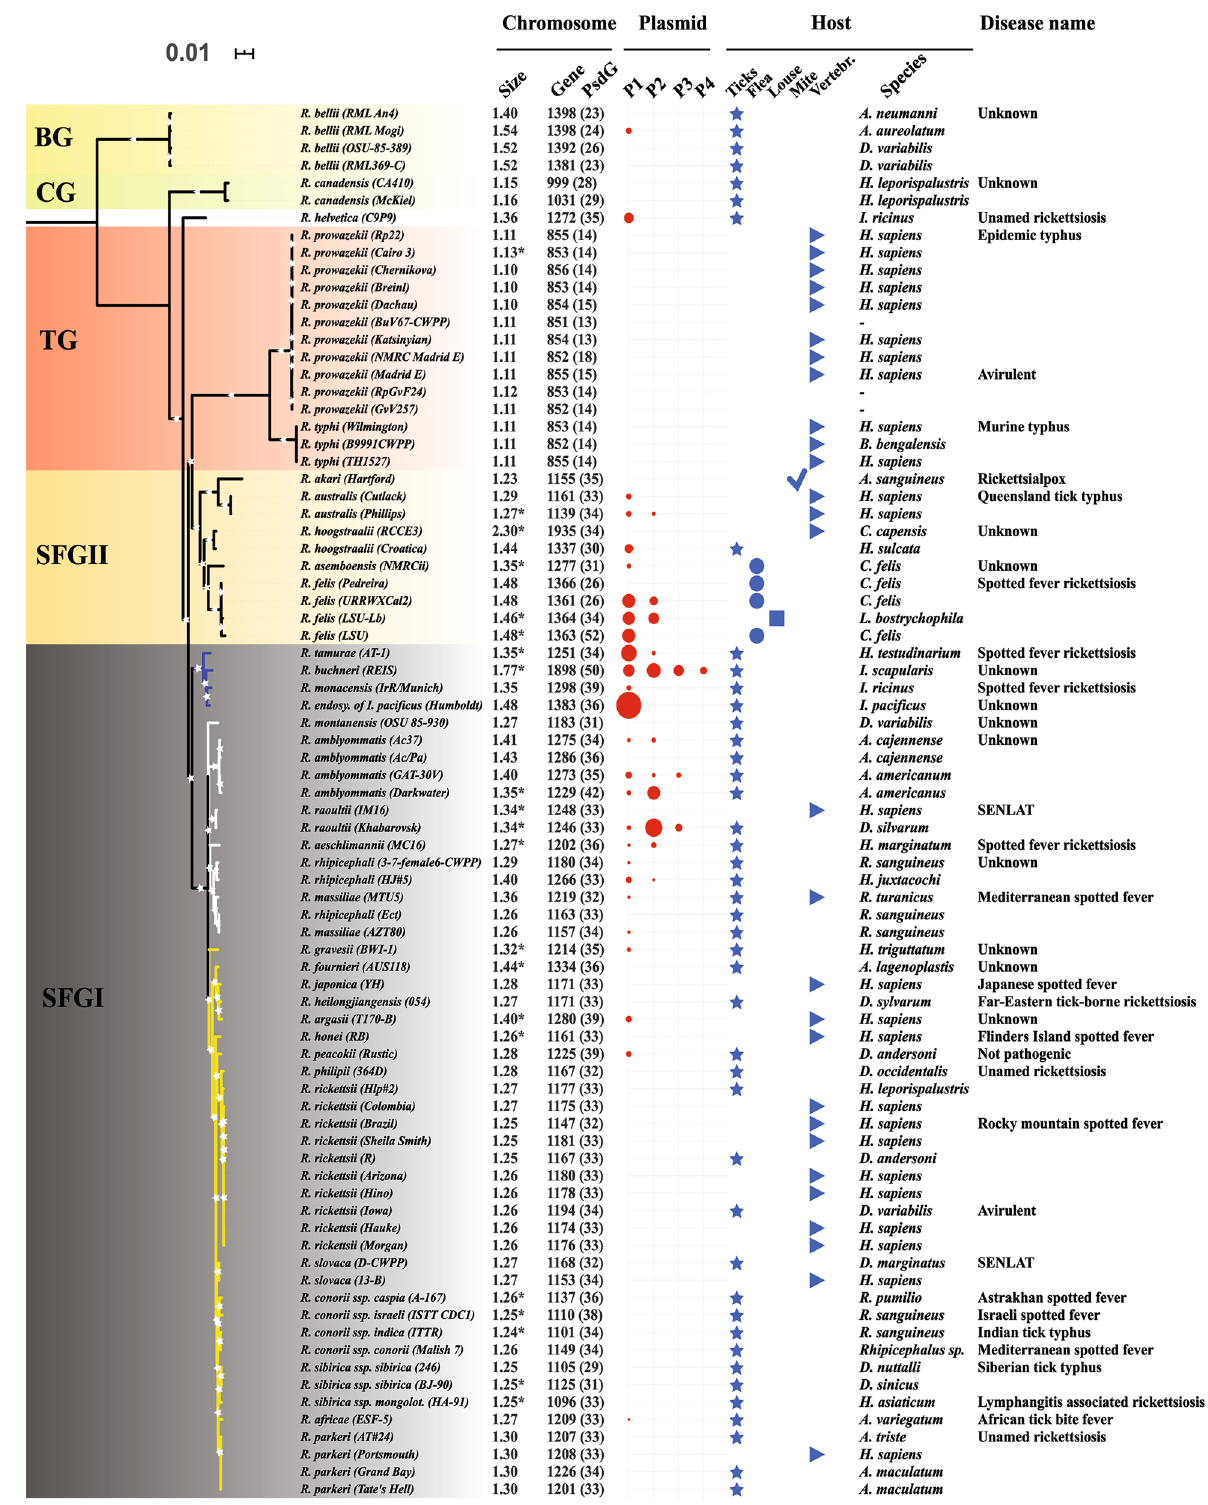
Figure 1. Maximum likelihood phylogenomic tree of arthropod-associated Rickettsia spp. estimated from 461 core chromosomal genes containing 36,880 core genes of 34 species and 80 strains. For each strain, the columns show its chromosome size, gene content (pseudogenes in %), number of plasmids and their sizes (presented by the diameter of circles) and host (either familiar or taxonomic name), as well as the name of the disease that it causes in humans. A : Amblyomma , H : Homo sapiens , D : Dermacentor , R : Rhipicephalus , A. lagenoplastis : Argas lagenoplastis , H . leporispalustris/juxtacochi/sulcata : Haemaphysalis leporispalustris/juxtacochi/sulcata , H. asiaticum/marginatum/testudinarium/triguttatum : Hyalomma asiaticum/marginatum/testudinarium/ triguttatum , I : Ixodes , A . sanguineus : Allodermanyssus sanguineus , C : Ctenocephalides , L : Liposcelis , C . capensis : Corvus capensis and B : Bandicota